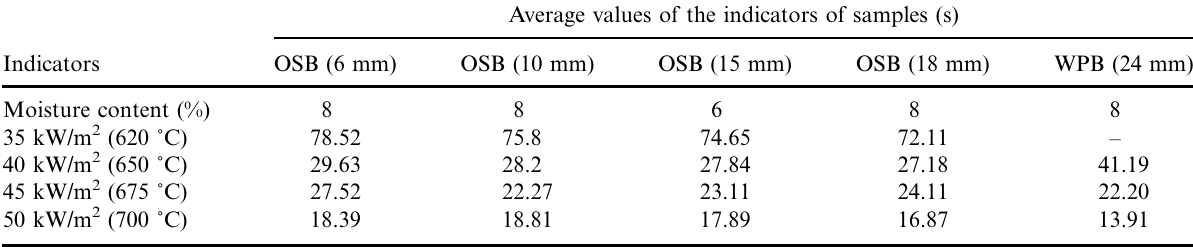
Table 2. The average moisture content and the TTI of impregnated wood products exposed to heat flows of different capacities (temperature)